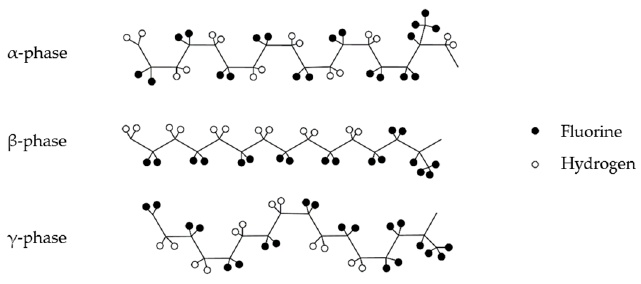
Figure 3. The α -phase, β -phase, γ -phase crystal structures of PVDF-HFP demonstrating the α -phase is far less polar than the β -phase. Ratio of PVDF:HFP ~ 15:1 (HFP structure on the right).